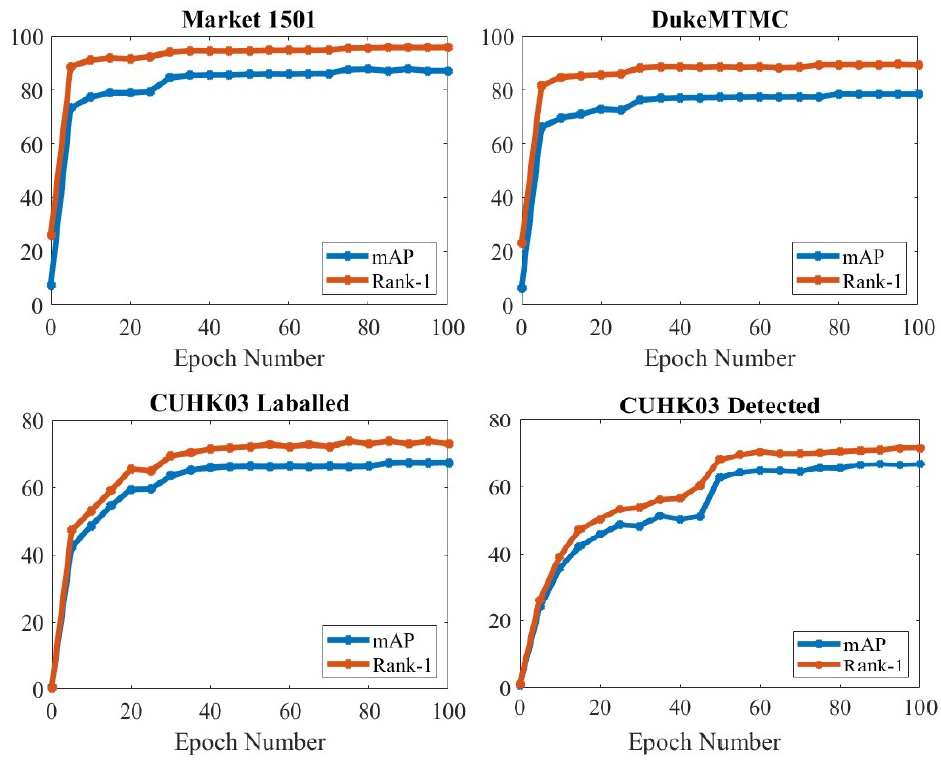
Figure 7. Effect of different numbers of epochs on the Market-1501, DukeMTMC, and CUHK03 (labeled and detected)